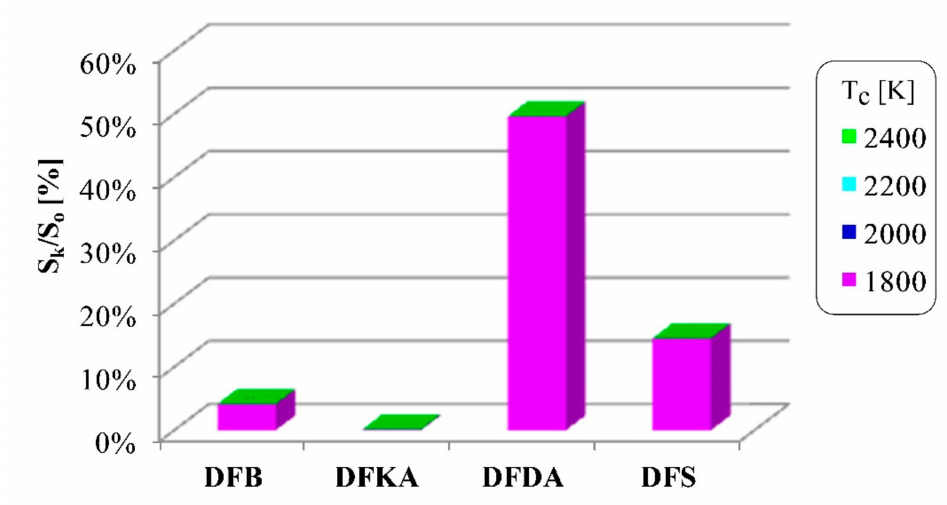
Figure 30. Surface area S k of flame in kinetic combustion phase covered by isotherms with specific temperatures (relative to measuring surface area S o ) for tested